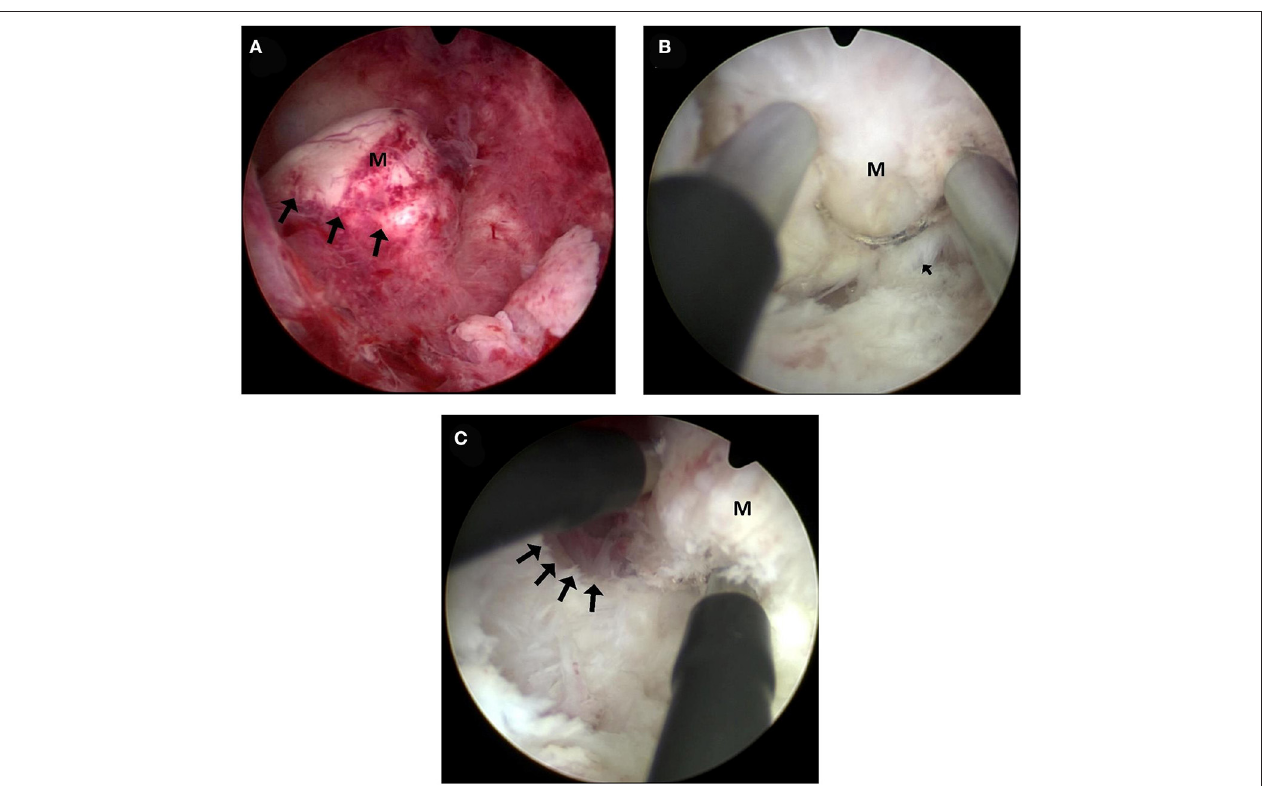
FIGURE 1 | Hysteroscopic images of the modified technique. (A) Submucous fibroid under hysteroscopy. Arrows indicate the places where the endometrium would be cut open. M: submucous fibroid. (B) A space between the fibroid and the myometrium was opened. The bipolar loop with the energy of coagulation was used to lacerate the connective tissue bridges (arrows) along the surface of the fibroid. The fore-end of hysteroscope was inserted into the plane and used in a mechanical way along the surface of the fibroid. M: submucous fibroid. (C) Enucleation of the intramural component of the fibroid. At the end of the enucleation phase, the intramural part of the fibroid was almost dislocated into the uterine cavity. M: submucous